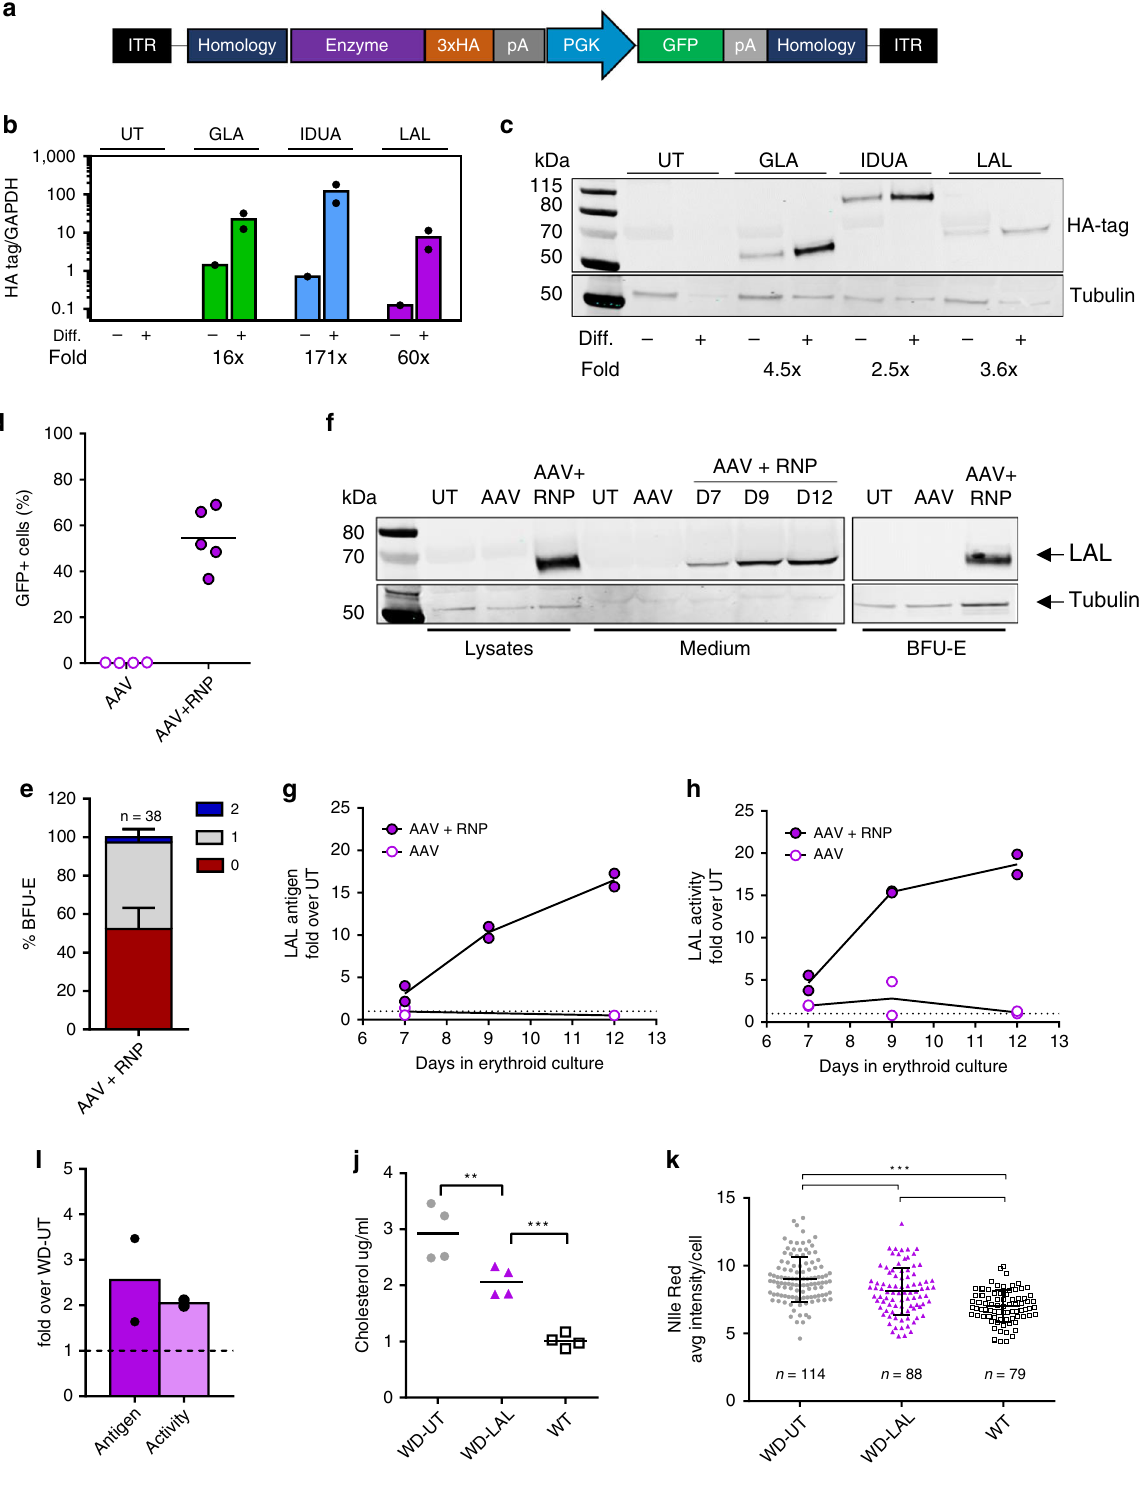
describing AAV toxicity in HSPCs 28,29 , KI HSPCs showed lower engraftment levels compared to unedited HSPCs (Fig. 5b) and a reduction of KI GFP positive cells after